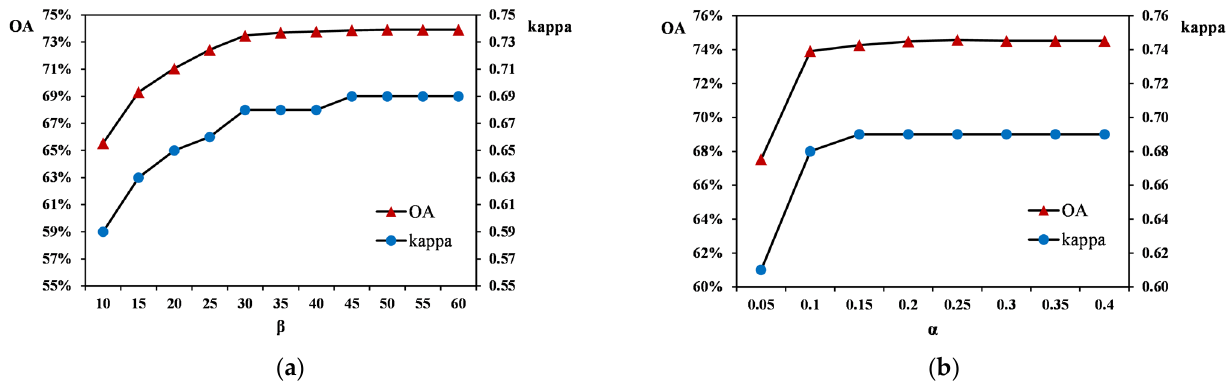
Figure 8. Parameter settings of TWDTW. ( a ) OA/kappa- β ( α = 0.1). ( b ) OA/kappa- α ( β =